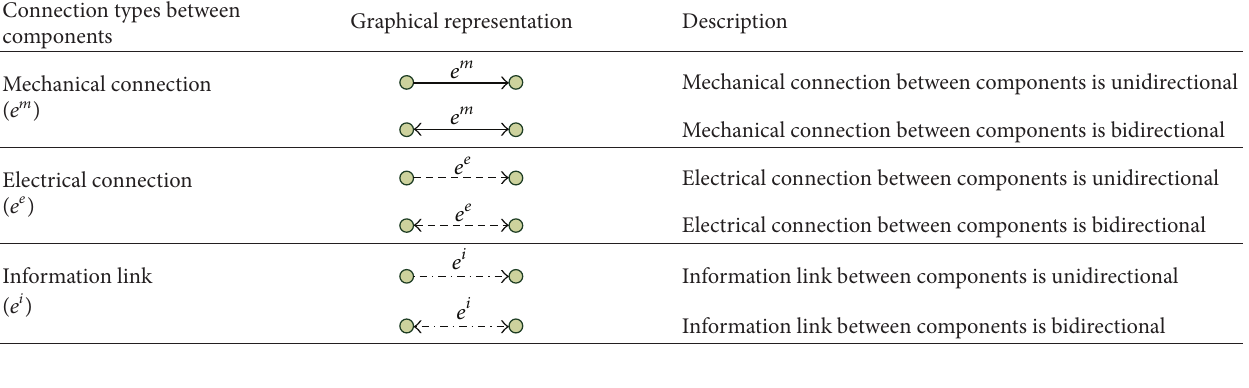
Table 1: The formal expression of system’s connections.